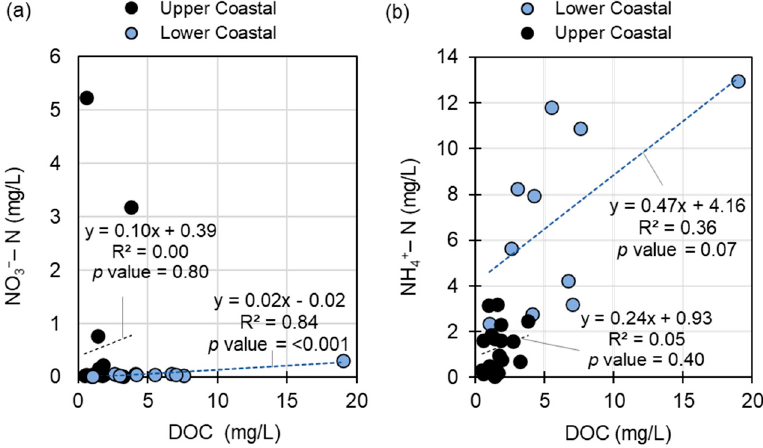
Figure 6. Relationship of dissolved organic carbon (DOC) with NO 3 − –N ( a ) and NH 4 + –N ( b ) in the groundwater samples.